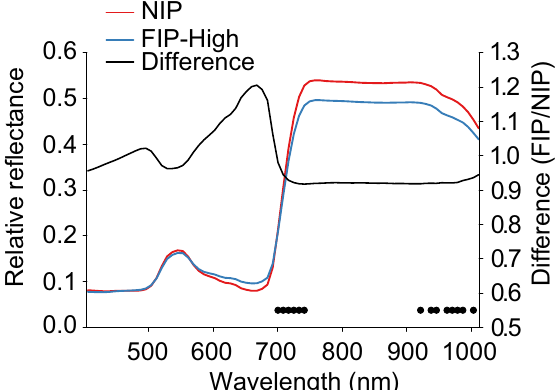
Figure 2. Average leaf reflectance from non-inoculated control plants (NIP) and root-associated entomopathogenic fungal (R-AEF)-inoculated plants at high concentration of fungal inoculum (FIP-High), and the “difference”. Black dots indicate spectral bands, in which average reflectance varied significantly between the two treatments (p < 0.05).